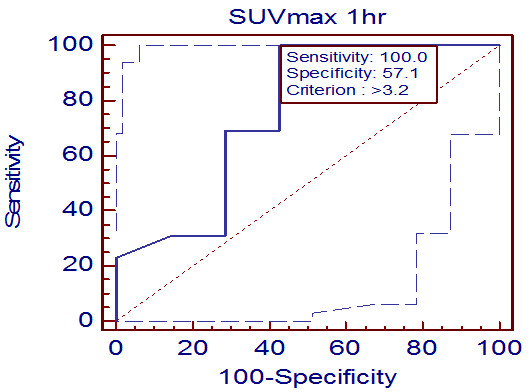
Receiver operating curve analysis of standardized uptake value (SUV)max1. The sensitivity and specificity were calculated when the SUVmax1 cutoff value was set at 3.2.